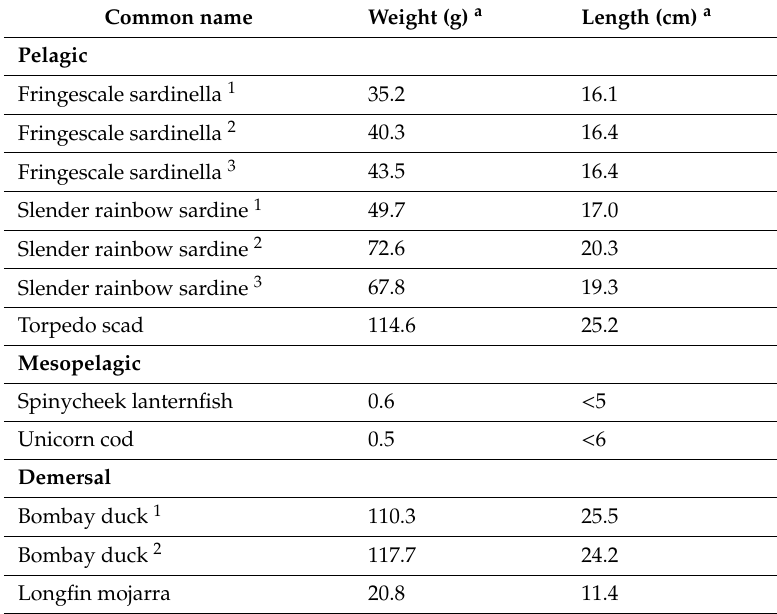
Table 2. Mean physical parameters of fish species sampled from Bangladesh.